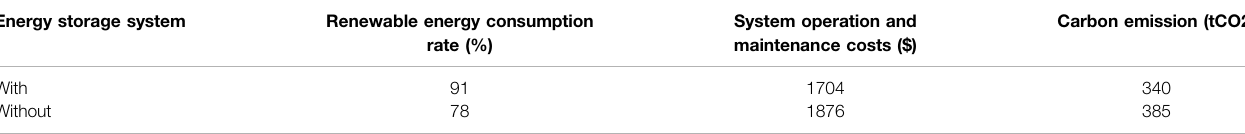
TABLE 4 | Performance comparison of integrated energy systems before and after access to multiple types of energy storage. Energy storage system